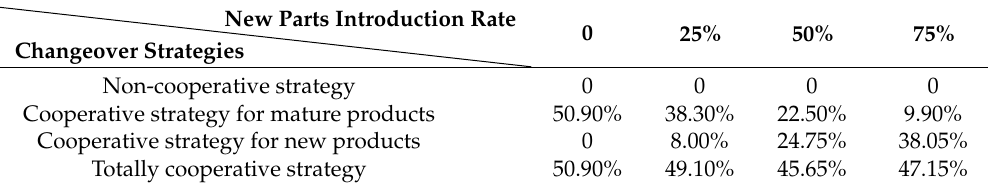
Table 7. Correlation analysis of the cooperation rate and the workload balance level.